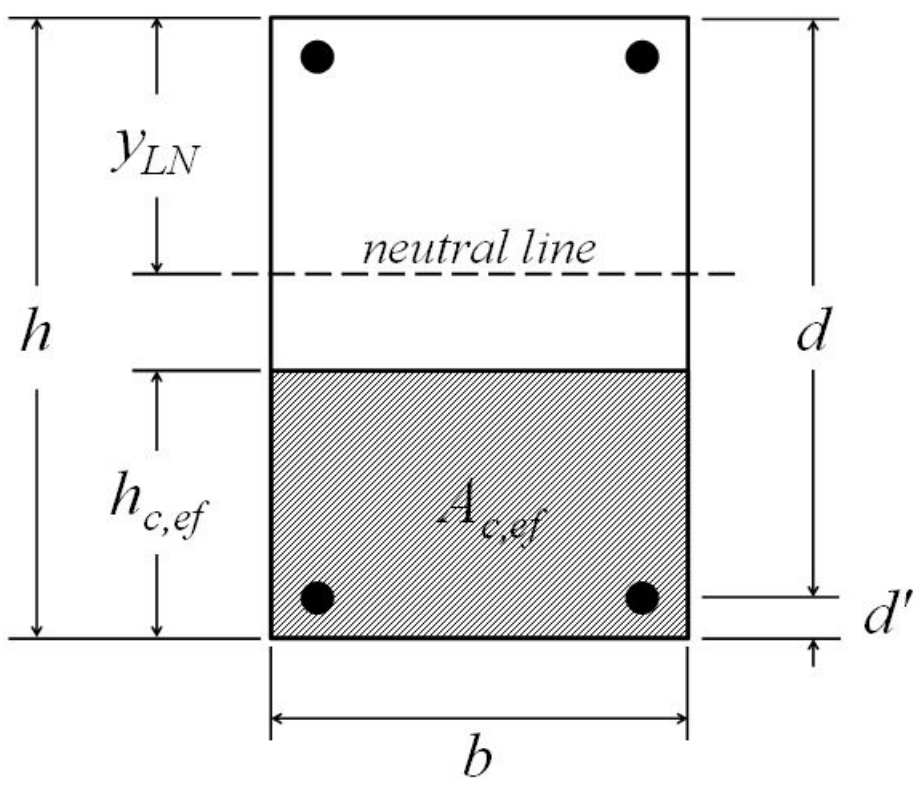
Figure 9. Rectangular block corresponding to the effective tension